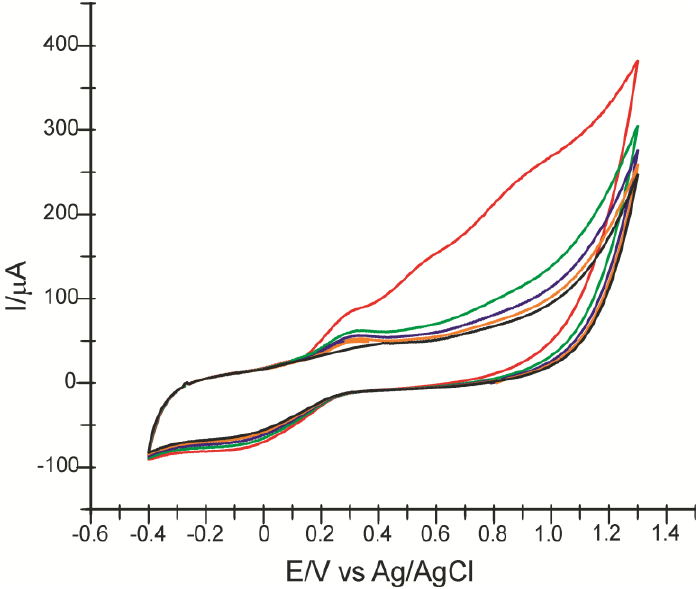
Figure 10. Cyclic voltammograms recorded with CNF/C-SPE immersed in Eye Blend solution (1 cps/50 mL PBS 0.1 M, pH 7.0): first scan—red line, second scan—green line, third scan—blue line, fourth scan—orange line, fifth scan—black line.